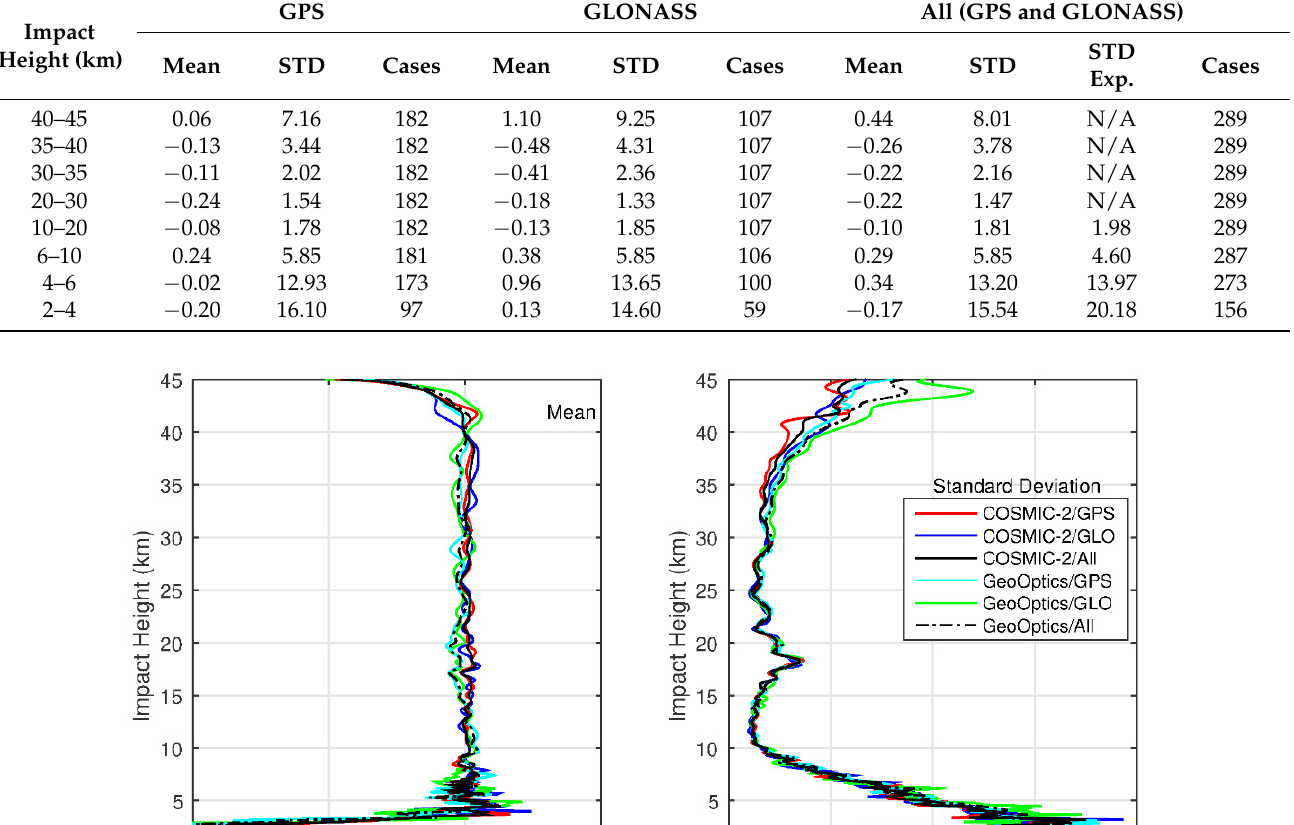
Table 1. Bending angle comparison (relative difference %) between GeoOptics and COSMIC-2 for GPS, GLONASS, and GNSS satellites. Only the bending angles from both COSMIC-2 and GeoOptics with valid data at the given impact height interval are included in the statistics.